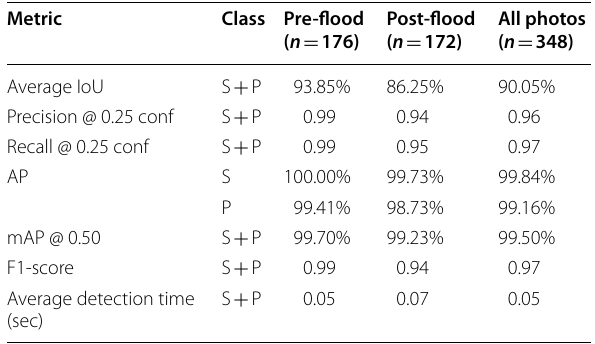
Table 3 Performance of the trained model in detecting stop signs and poles in pre- and post-flood photos of the test set (S: Stop sign; P: sign pole; S P: stop sign and sign +